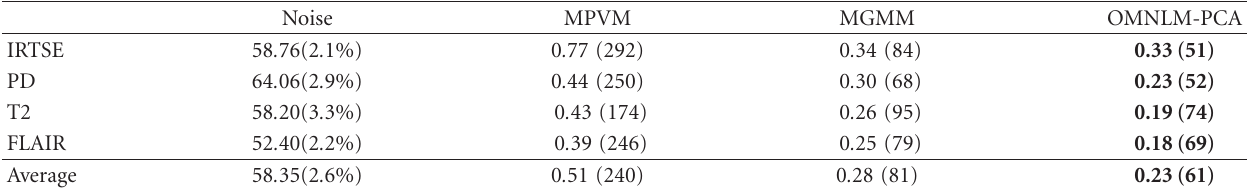
Table 4: Comparison of the results of the di ff erent filters. RNF following filtering and data lying beyond 3 SD of original value following filtering (in brackets). The expected number of outliers was 60 for the selected brain